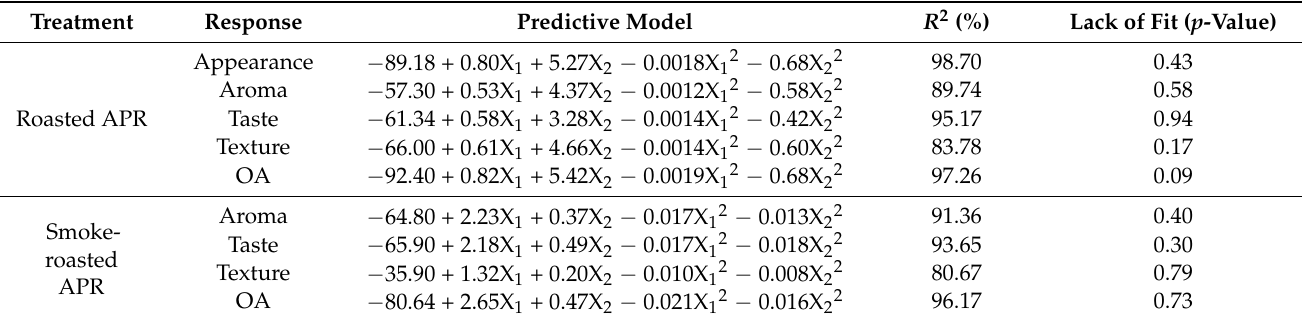
Table 4. The response surface model of appearance, aroma, taste, texture, and overall acceptance (OA) of roasted and smoke-roasted Alaska pollack roe (APR) with different temperatures (X 1 ) and times (X 2 ).